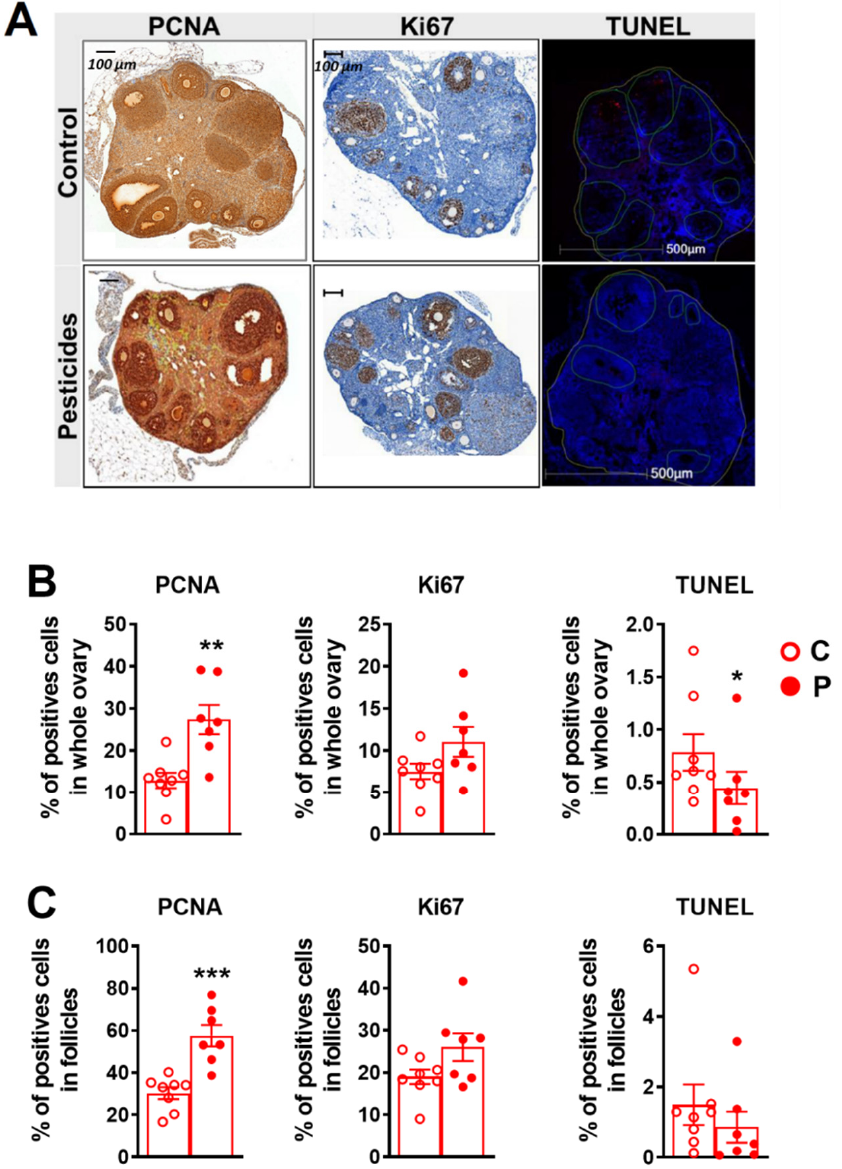
Figure 5. Percentage of positive cells in PCNA, KI67 and tunnel assay in ovaries from seven pesticide-exposed (P) and eight unexposed female (C) offspring. Data are presented as mean ± SEM. * p < 0.05, ** p < 0.01, *** p < 0.001 for P vs. C in whole ovary ( B ) and specifically in follicles ( C ). ( A ) PCNA and Ki67 immunostaining and TUNEL nuclear fluorescence, of murine ovary sections in control and pesticide-exposed female offspring. Five sections per ovary were assessed for the whole section and within regions of interest (ROI), i.e., follicles manually selected using Definiens ® software v2.7 (Munchen, Germany) for PCNA and Ki67 assay and Halo ® software v3.4 (IndicaLabs, Albuquerque, NM, USA) for TUNEL assay.